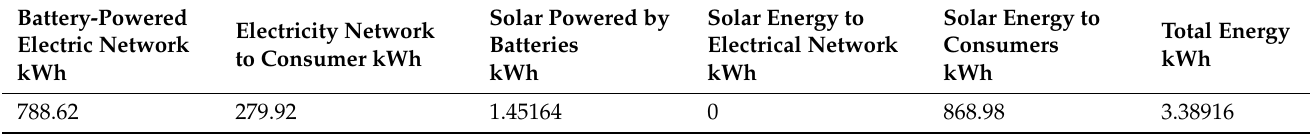
Table 12. Generation and electric consumption of the solar vessel “INER